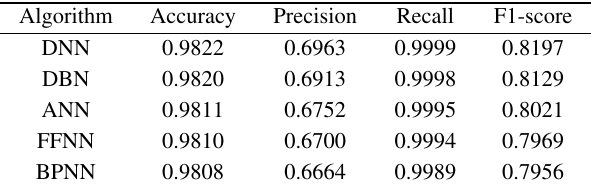
Table 6 Performance of ritonavir drug interaction with SARS-CoV-2 virus over Indian